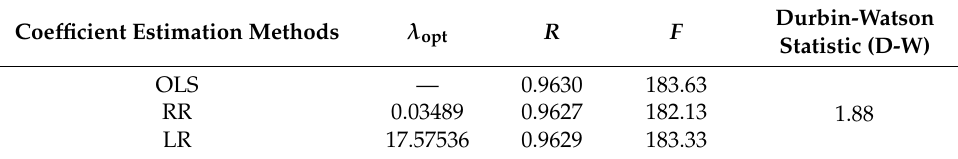
Table 6. Significance test results of the regression